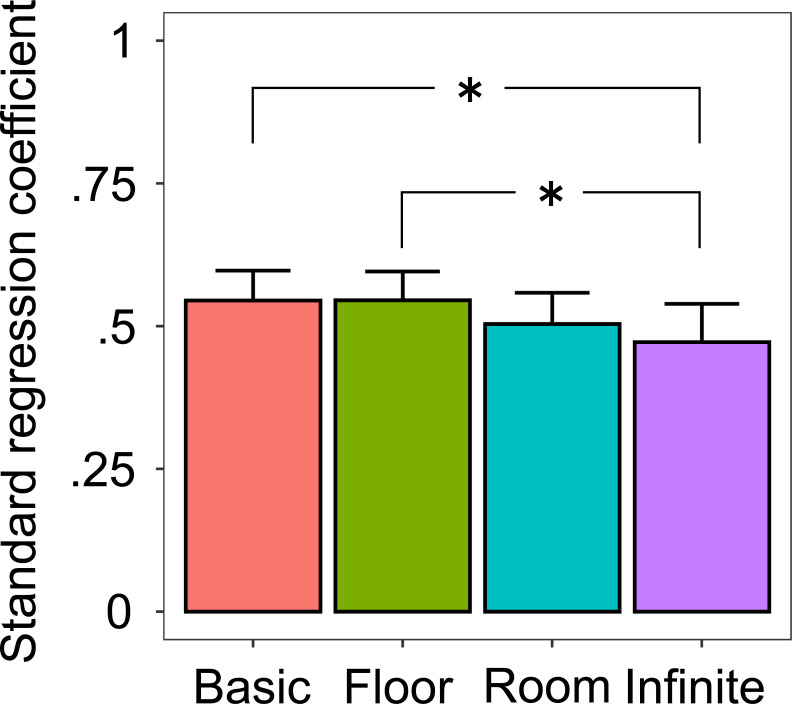
Effect of 360-degree spatial contexts on horizontal allocation of attention.Bars represent the mean standard regression coefficients as a function of target longitude. Error bars represent 95% confidence intervals. Asterisks represent significant differences (p < .05).